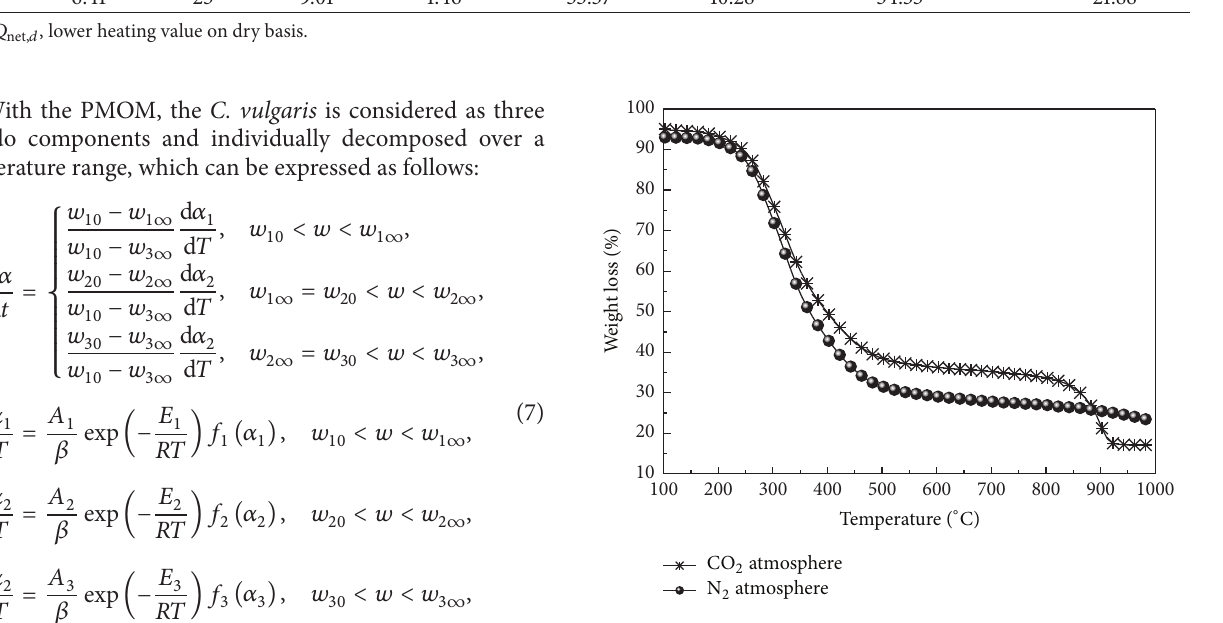
Figure 1: TG curves of Chlorella vulgaris decomposition at a heating rate of 10 ∘ Cmin −1 in N 2 and CO 2 atmospheres.